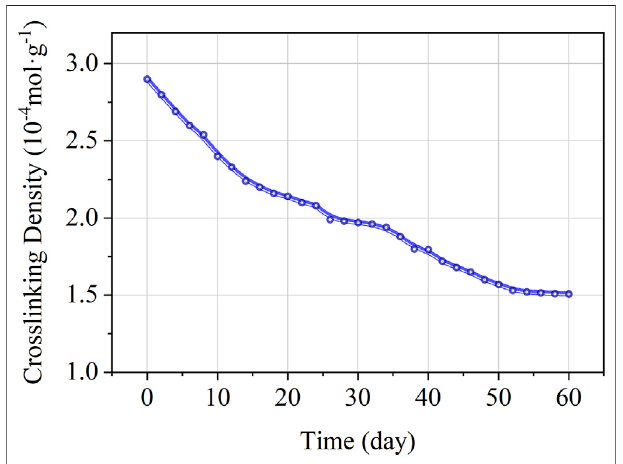
FIGURE 4 | The crosslinking density of the waste silicone rubber.